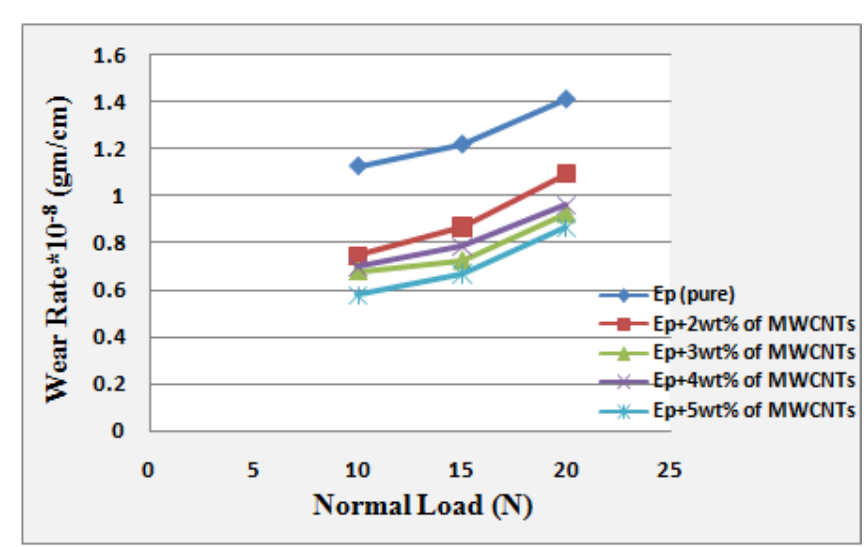
Fig. 6: The effect of applied load on wear rate for Ep/MWCNTs nanocomposites after immersion.